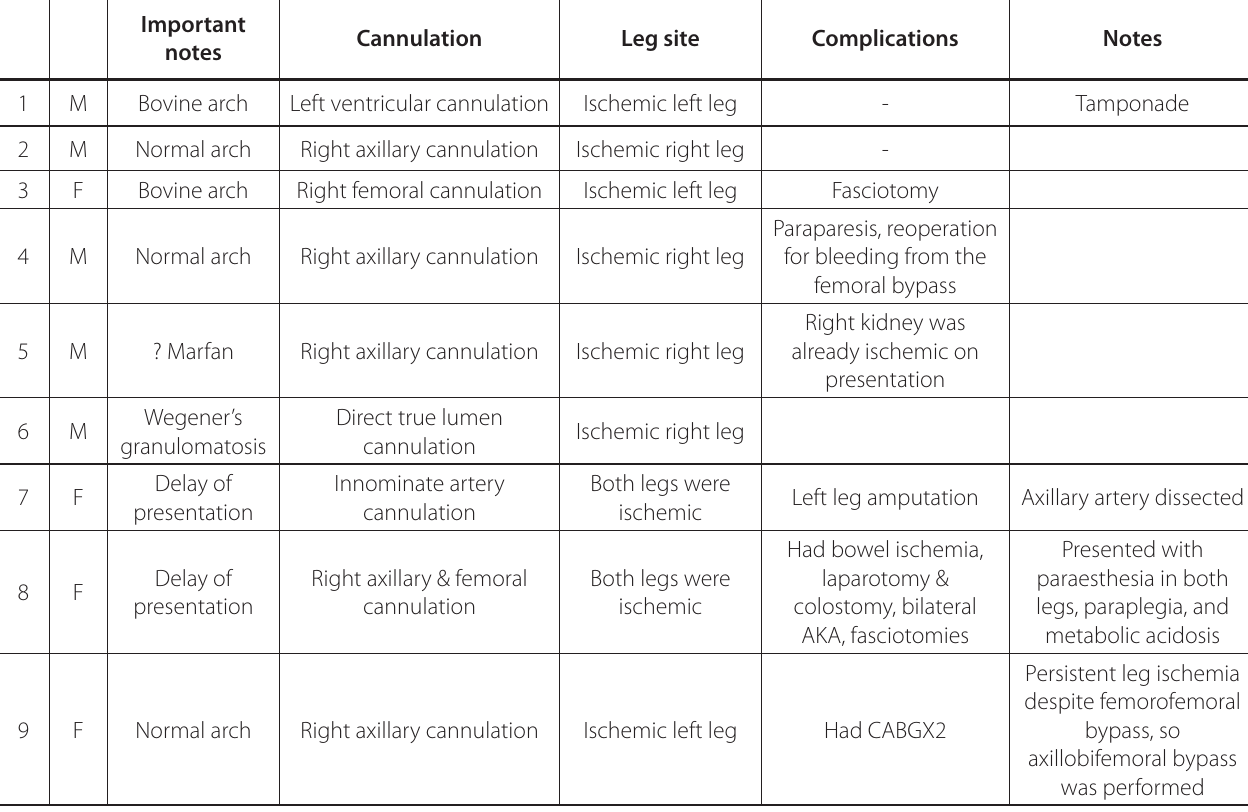
Table 1 . Characteristics of the nine patients operated with femorofemoral